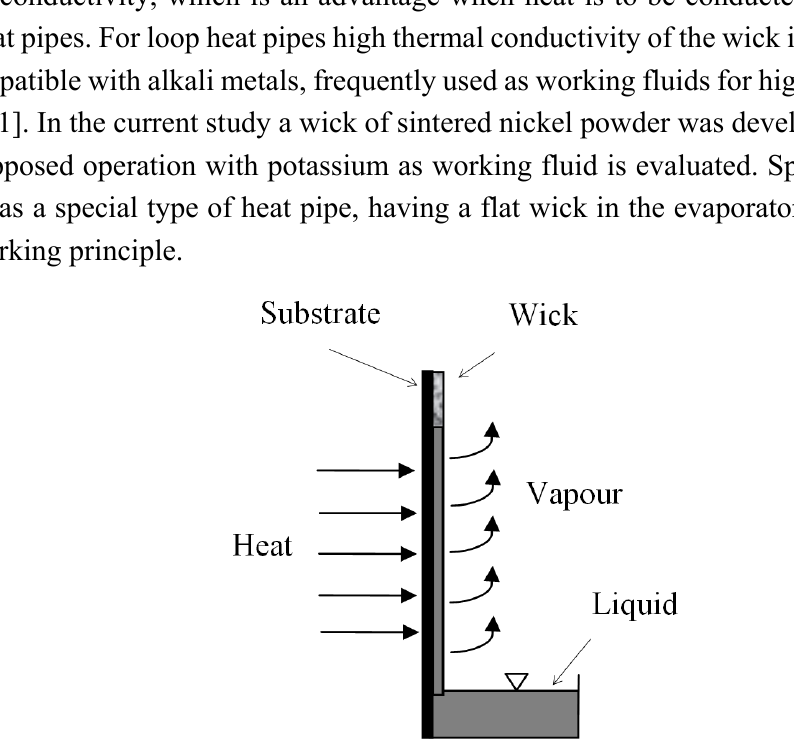
Figure 1. A flat wick attached to a solid substrate subject to a uniform heat flux